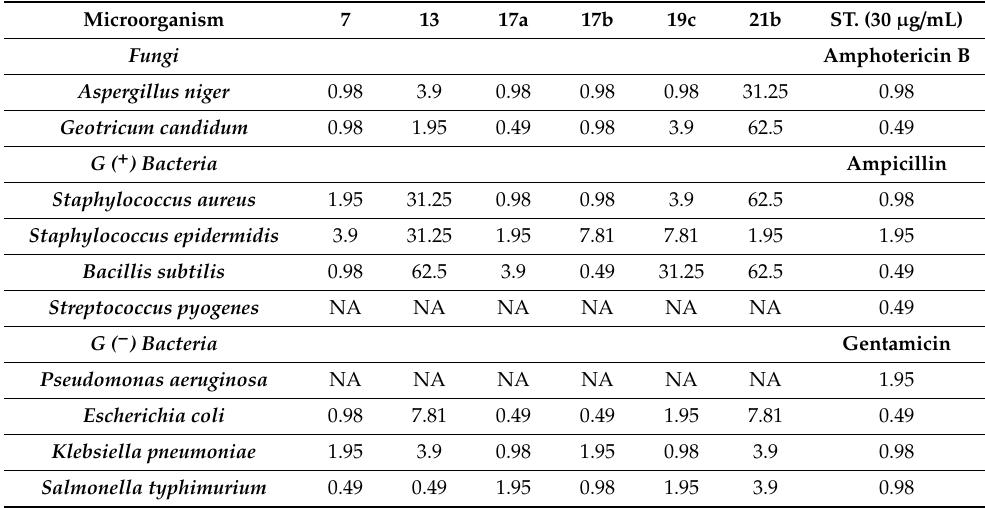
Table 7. Minimum inhibitory concentration of compounds 7 , 13 , 17a , b , 19c and 21b ( µ g /